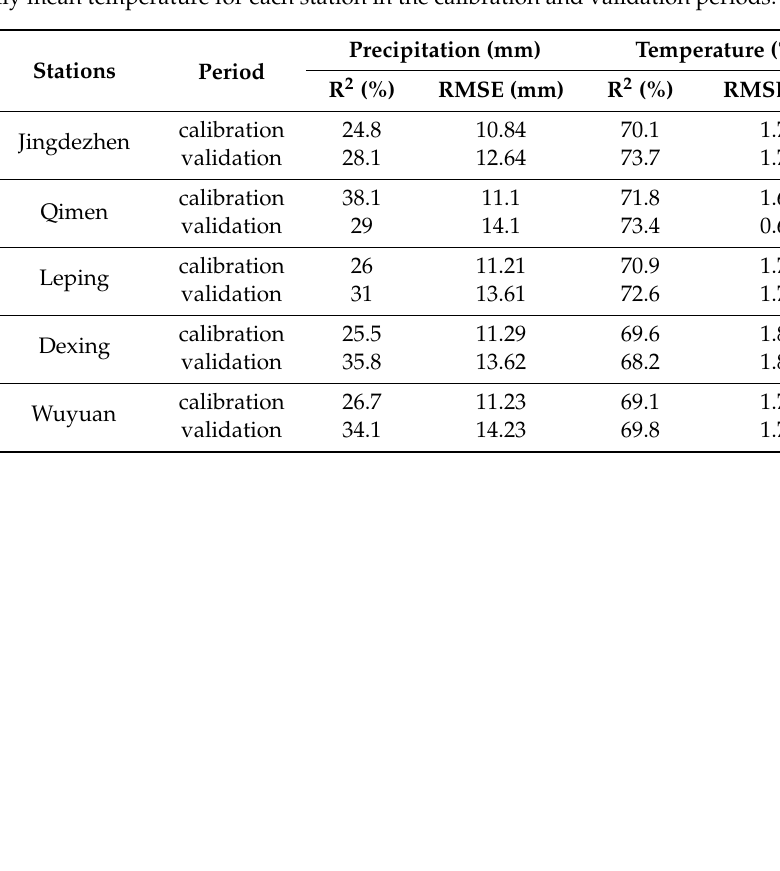
Table 3. The coe ffi cient of determination (R 2 ) and root mean square error (RMSE) of daily precipitation and daily mean temperature for each station in the calibration and validation